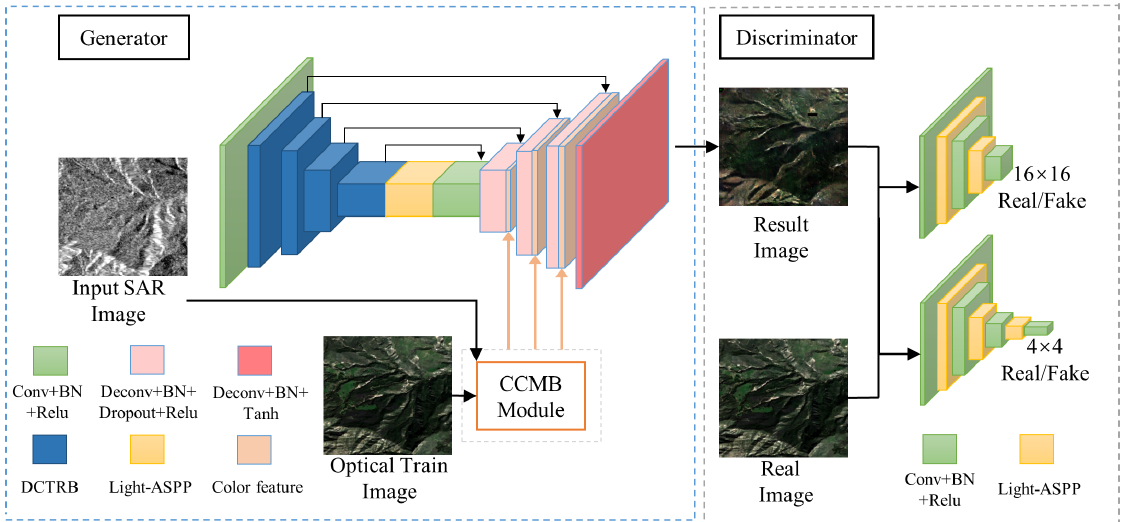
Figure 2. The overall architecture of Sar2color. Best viewed in color.